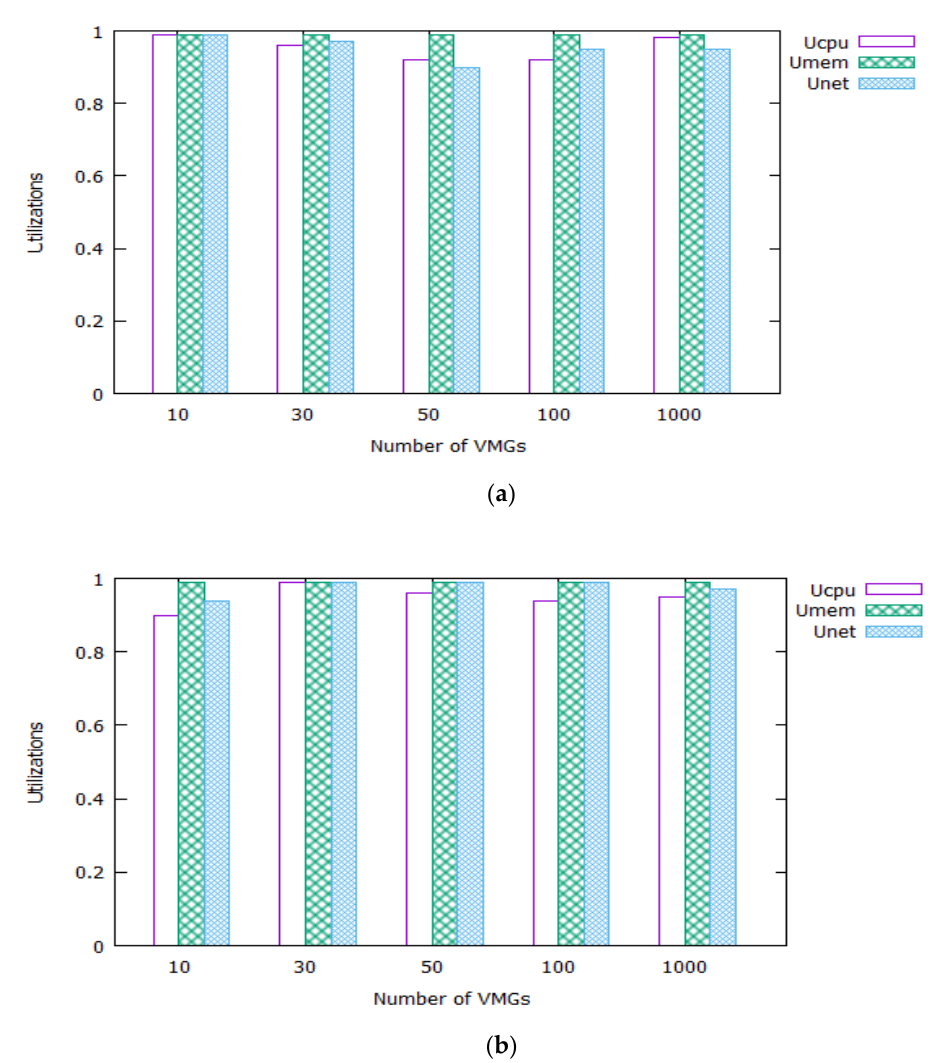
Figure 11. Average utilization ( U CPU , U MEM , and U NET ) with optimal CMP configuration: ( a ) Simulation results on Windows distributed platform; ( b ) Simulation results on Linux distributed platform.